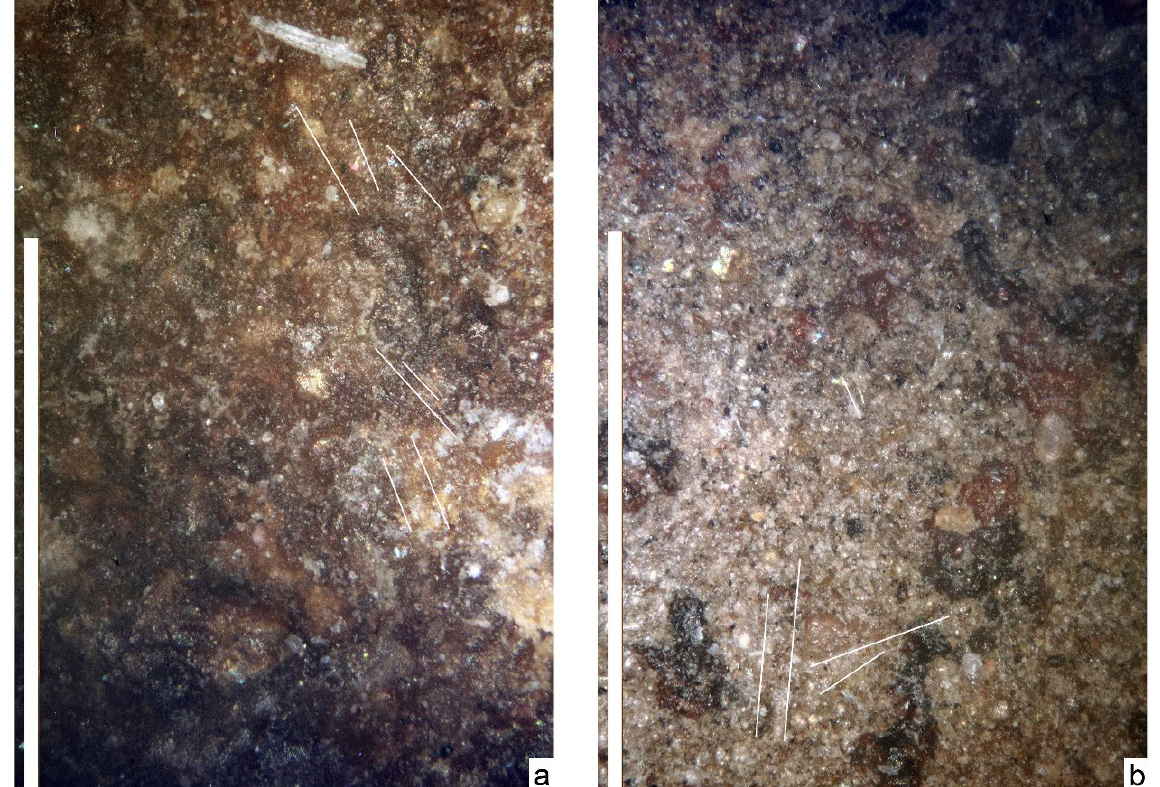
Figure 12. Micro-photo of the working surfaces of the ethnographical lower grinding stone (a - 100×, scale bar = 1 mm) and mano (b - 100×, scale bar = 1 mm). White lines in the micro-photo emphasize thin thread-like linear